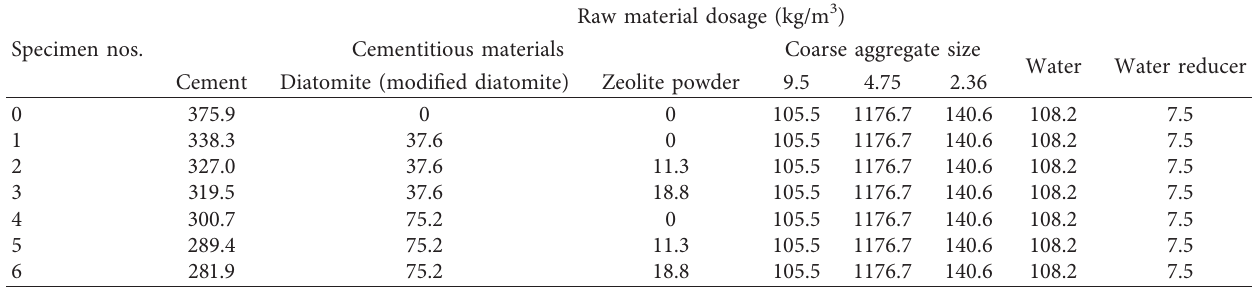
Table 6: Mix proportion of permeable concrete.